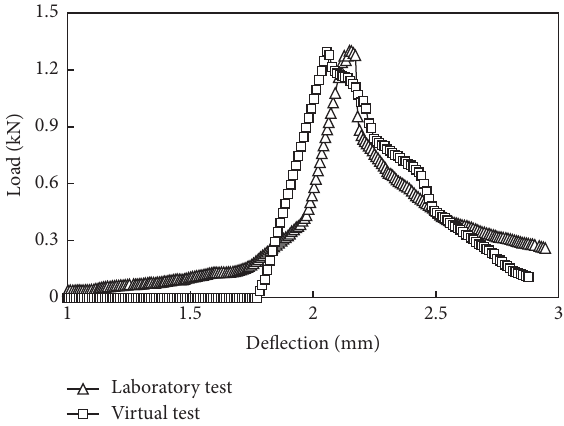
Figure 6: Testing results from laboratory test and virtual test.